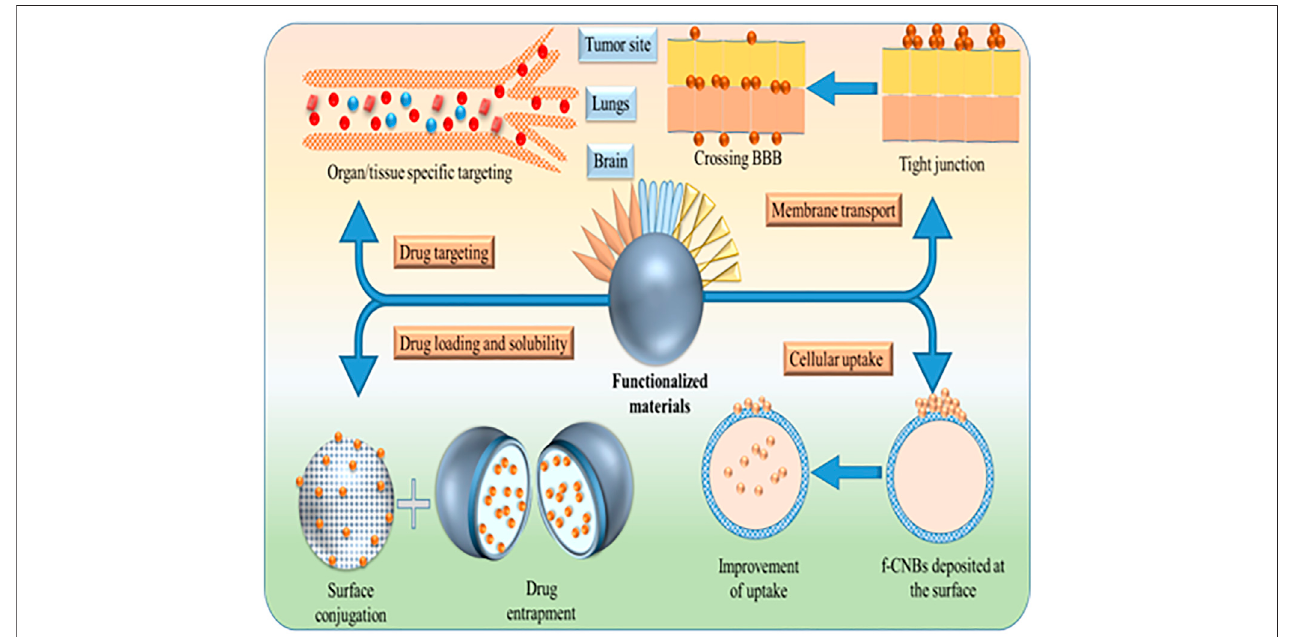
FIGURE 4 | Application of functionalized CBNs in drug